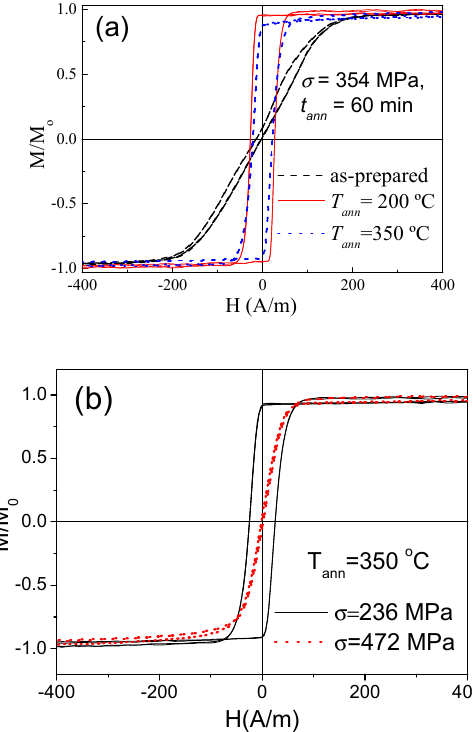
Figure 6. E ff ect of T ann , for σ = 354 MPa ( a ) and e ff ect of σ for T ann = 350 ◦ C ( b ), on hysteresis loops of Figure 6. Effect of T ann , for σ = 354 MPa ( a ) and effect of σ for T ann = 350 °C ( b ), on hysteresis loops of studied studied samples.